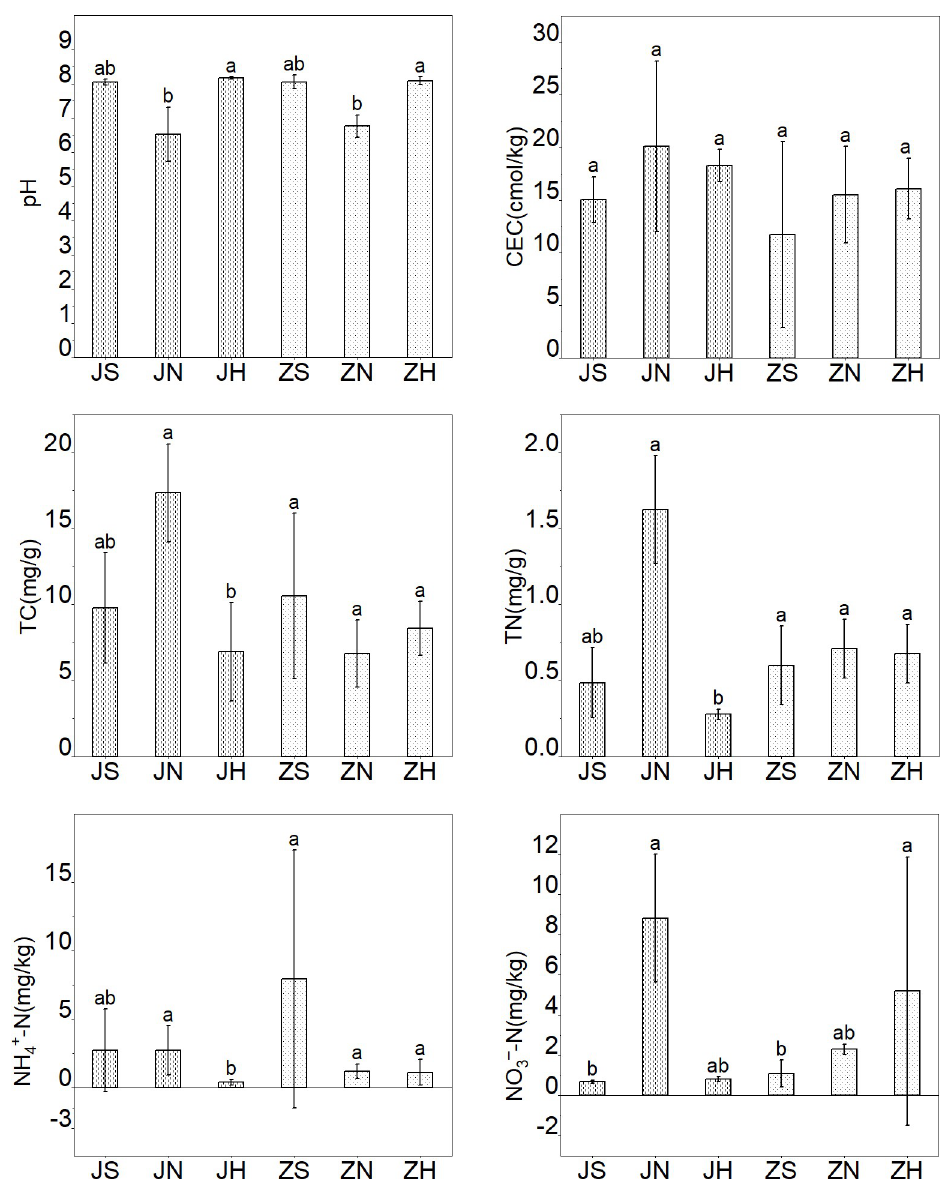
Fig 5. Soil properties in different habitats in JWP and ZWP. JWP: Shili Lake Ecological Wetland Park; ZWP: Shandong Zoucheng Taiping National Wetland Park Error bars represent standard deviation of the mean (n = 5). CEC: soil cation exchange capacity; TC: total carbon; TN: total nitrogen; NO 3– -N: nitrate nitrogen; NH 4+ -N: ammonium nitrogen. Other abbreviations as in Fig 4. Different lowercase letters indicate significant differences ( p <